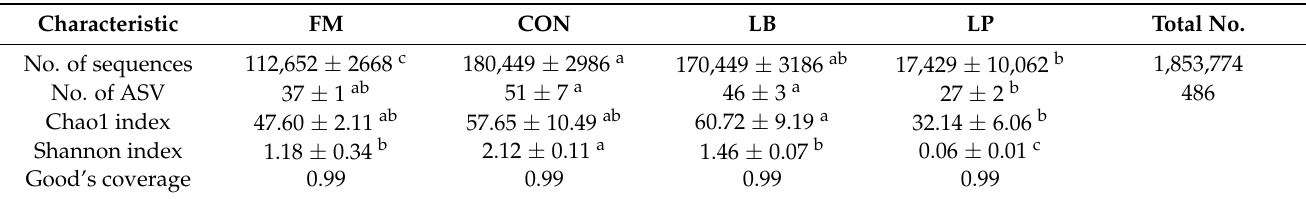
Table 4. Characteristics of amplicon libraries in the bacterial